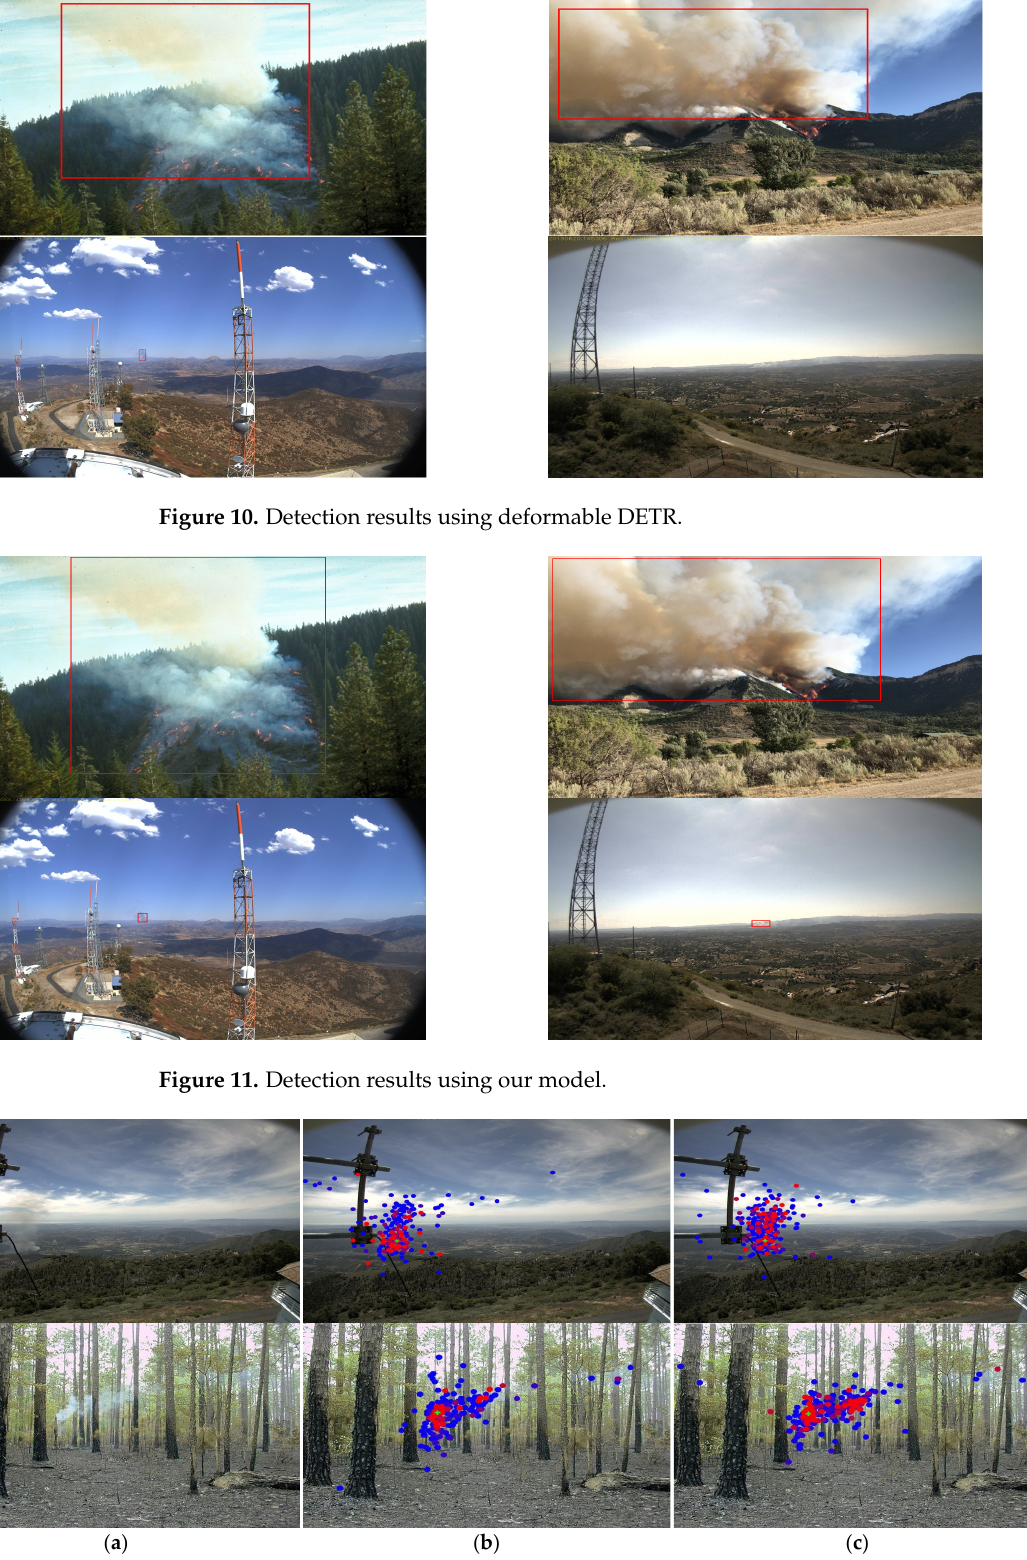
Figure 12. Visualization results of the multi-scale deformable attention in encoder. We draw the sampling points and attention weights from feature maps in one image. Each circle represents a sampling point and its color represents the attention weight. Color from blue to red indicates the weight from small to large. ( a ) Raw image; ( b ) deformable DETR; ( c ) our improved model.